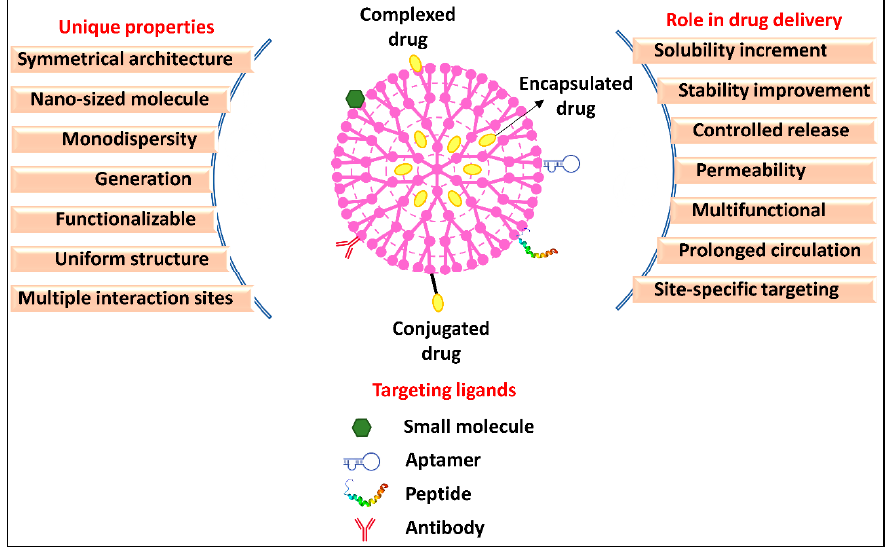
Figure 4. Dendrimer as a nanocarrier for anticancer drug